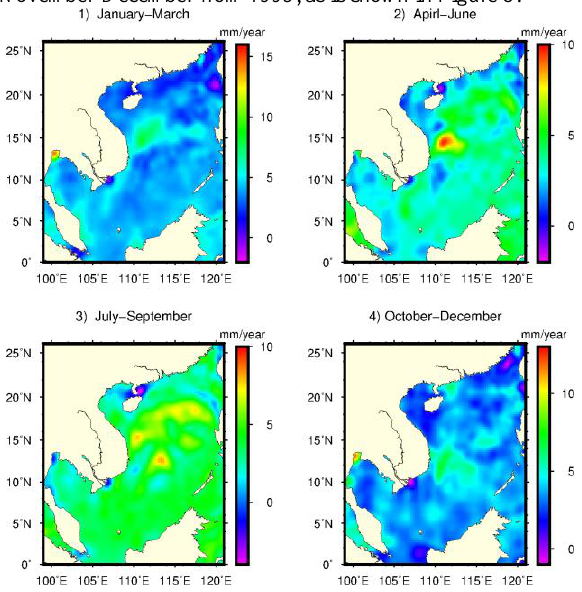
Figure 5. Satellite altimetry sea-level trend in four